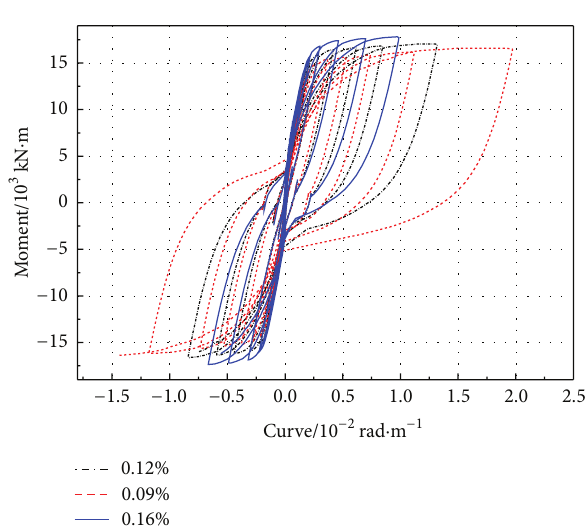
Figure 4: 𝑀 − 𝜑 curve of bottom section of PRC pier with different prestressed tendon ratios.